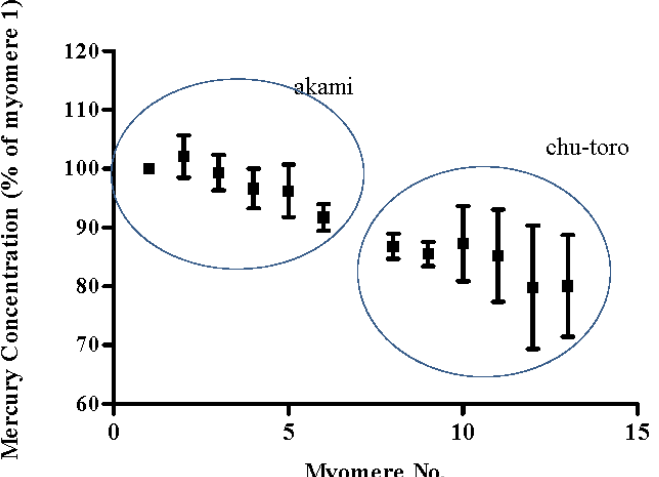
Figure 2. Systemic variation in the mean mercury concentration of muscle myomeres in the dorsal region of SBT steaks. Mercury concentration is presented as a percentage of myomere 1 mercury concentration.